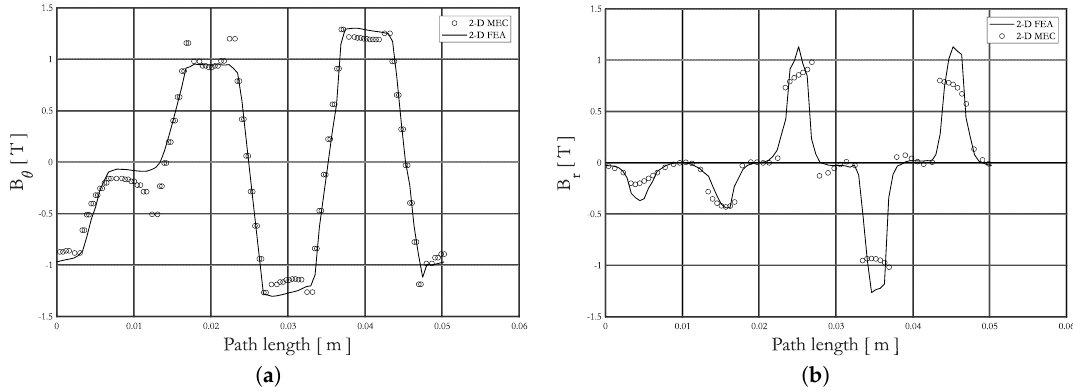
Figure 7. Waveform of B in the stator yoke: ( a ) tangential, and ( b ) radial component.